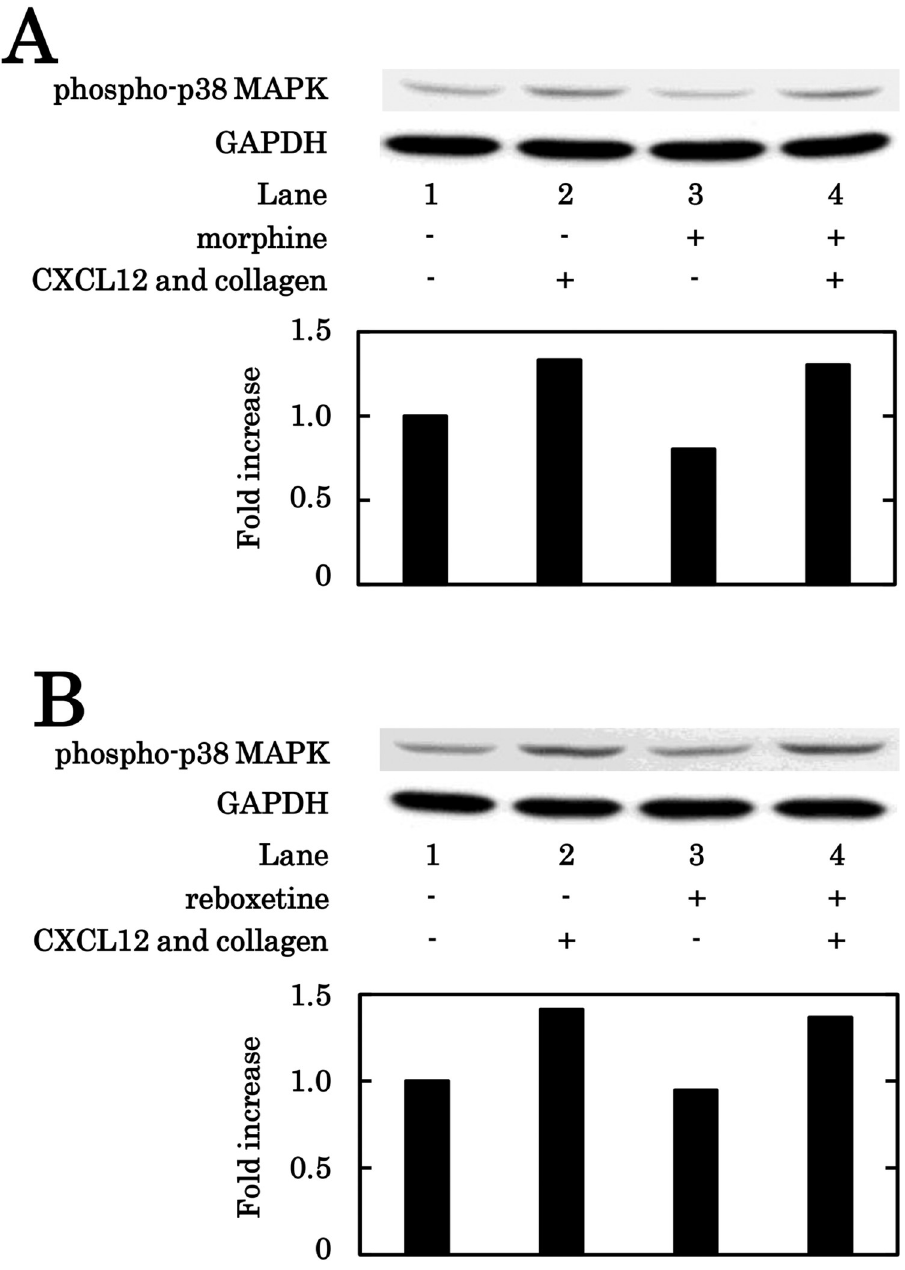
Fig 6. Effects of morphine or reboxetine on the phosphorylation of p38 MAPK in human platelets induced by simultaneous stimulation with collagen and CXCL12. PRP was pretreated with 200 μ M of morphine (A), 100 nM of reboxetine (B) or vehicle for 3 min, and then simultaneously stimulated by 0.2 μ g/ml (A) or 0.4 μ g/ml (B) of collagen and 10 ng/ml of CXCL12 for 5 min. The reaction was terminated by the addition of ice-cold EDTA (10 mM) solution, and the levels of phosphorylated p38 MAPK in the cell lysate of platelets were determined by the Western blot analysis using anti-phospho-p38 MAPK antibodies or anti-GAPDH antibodies. The champion data of 3 times independent experiments are